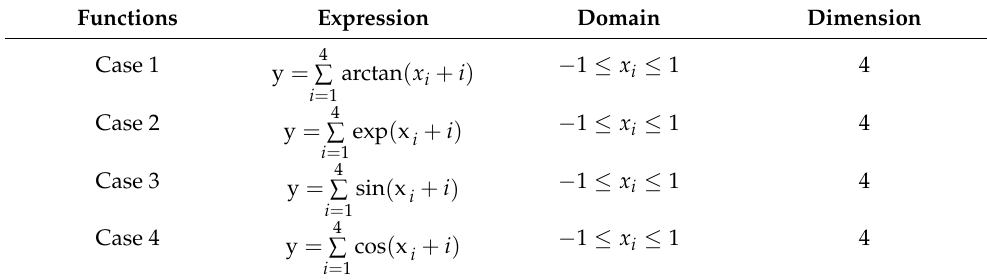
Table 4. Mathematical test